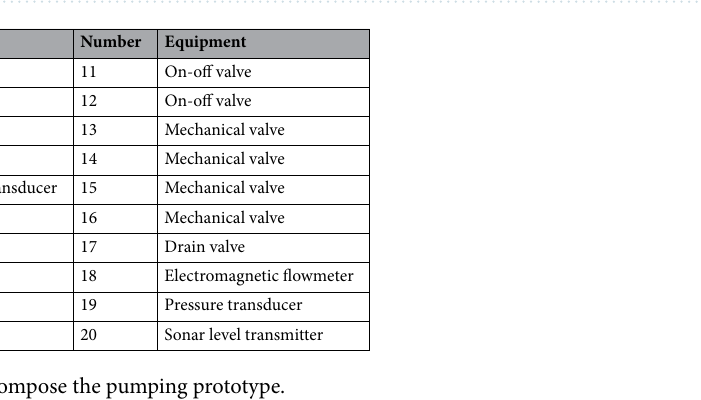
Table 1. Equipment that compose the pumping